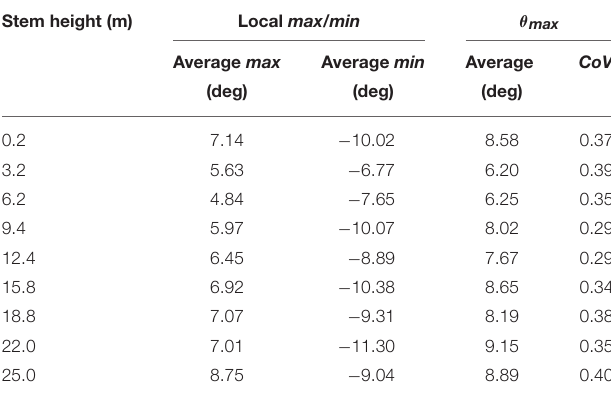
TABLE 4 | Average maxima tangential fibrovascular bundle degree of orientation ( θ max ) for the studied coconut palms. Stem height (m) Local max /